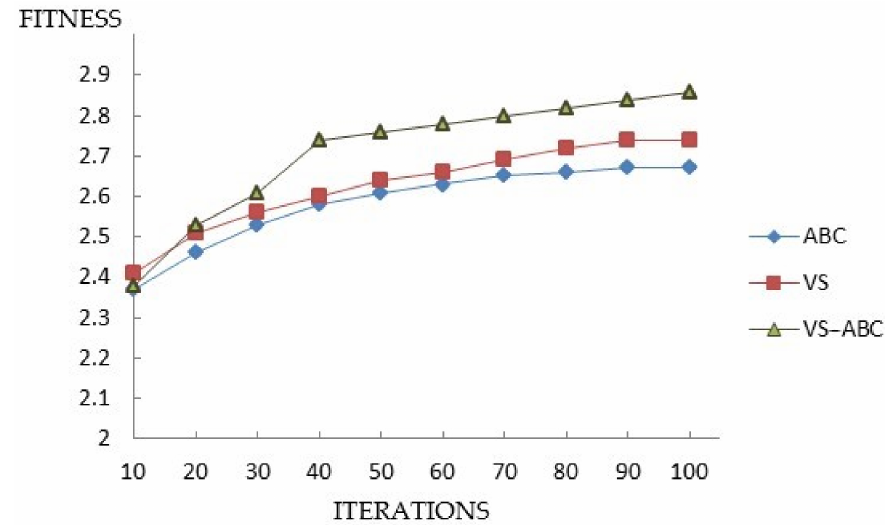
Figure 7. The trend of average fitness for 10 tasks for three algorithms.